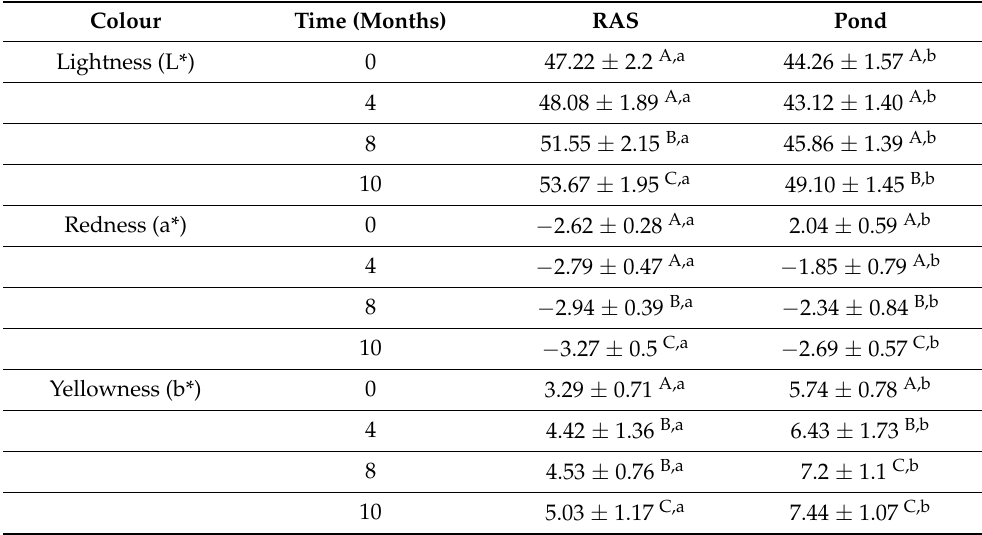
Table 3. Color changes in fish fillets from RAS and pond rearing systems during 10 months of frozen storage at − 20 ◦ C (mean ± S.D., n = 6).